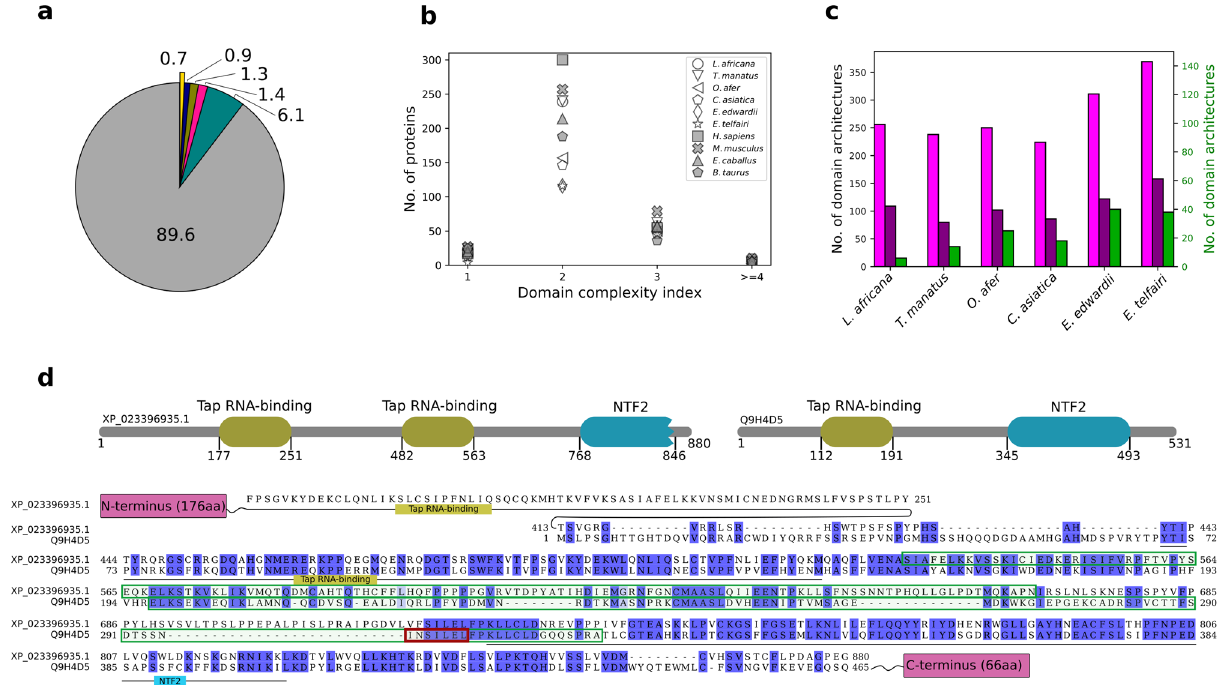
Figure 4. Distribution of functional domains in Afrotheria. ( a ) Pie chart shows the proportion of functional domains (in %) that are present in all (grey), in five (cyan), in four (pink), in three (olive), in two (navy) and in one (gold) of the Afrotherian species. 89.6% of all the total assigned functional domains are present in all the species while 0.7% of assigned domains are unique to any one species. ( b ) shows the distribution of KRAB domain containing proteins of varying domain complexity in various species. The number of these proteins varies most in proteins with domain complexity 2. ( c ) Bar plot shows the number of unique domain architectures in each of the Afrotherian proteomes (light magenta). Dark magenta bars show the number of unique architectures when tethered and repeat domains are not considered. Green bars, with y-axis scale on the right (in green font), show the number of novel domain architectures in each species, that are reported for the first time in Afrotheria through this study. ( d ) Domain assignments of a predicted L. africana nuclear RNA export 3 protein/NXF3 (XP_023396935.1) and its human homolog NXF3 (Q9H4D5). The limits of the domains are indicated by the residue positions on the assigned domains. Shown below is the sequence alignment of